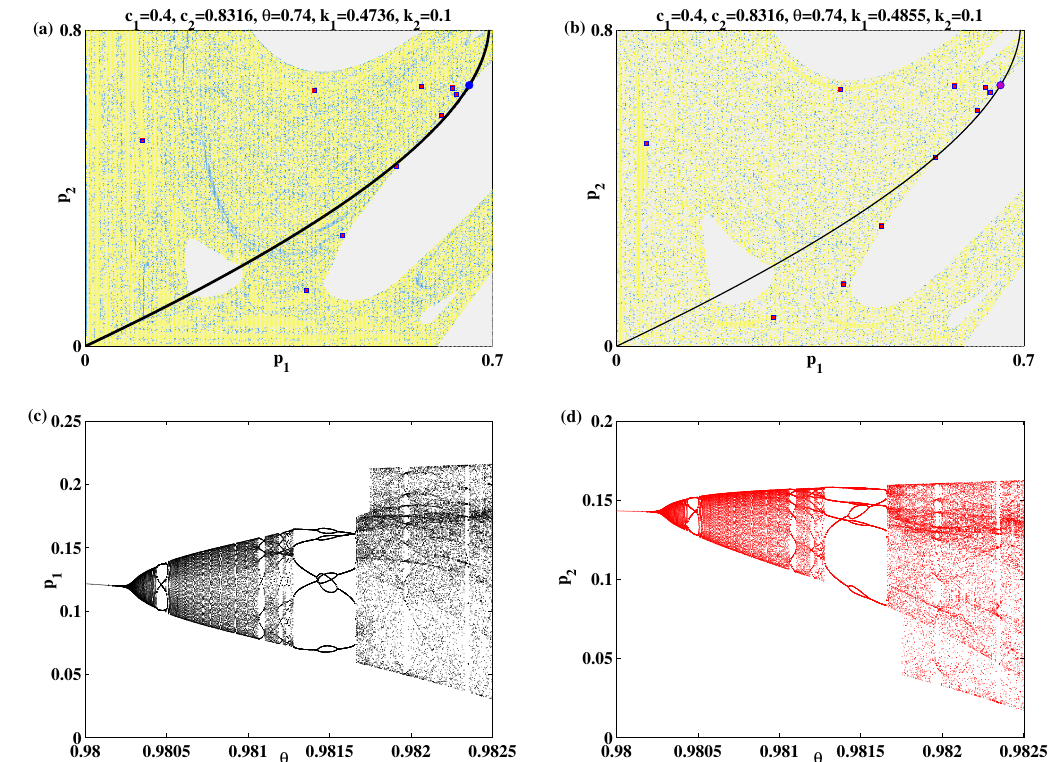
Figure 5. ( a ) The basin of attraction for the period-9 cycle. ( b ) The basin of attraction for the period-10 cycle. ( c ) Bifurcation diagram with respect to p 1 on varying θ at: c 1 = 0.2, c 2 = 0.1, k 1 = 0.1 and k 2 = 0.1. ( d ) Bifurcation diagram with respect to p 2 on varying θ at: c 1 = 0.2, c 2 = 0.1, k 1 = 0.1 and k 2 =